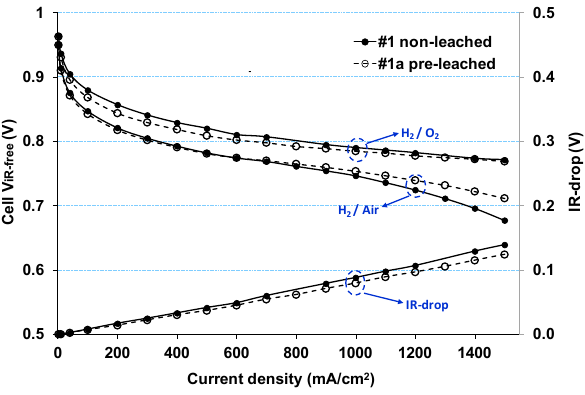
Figure 3. The beginning of life V-I performance of pre-leached and as made 4.9 nm Pt 3